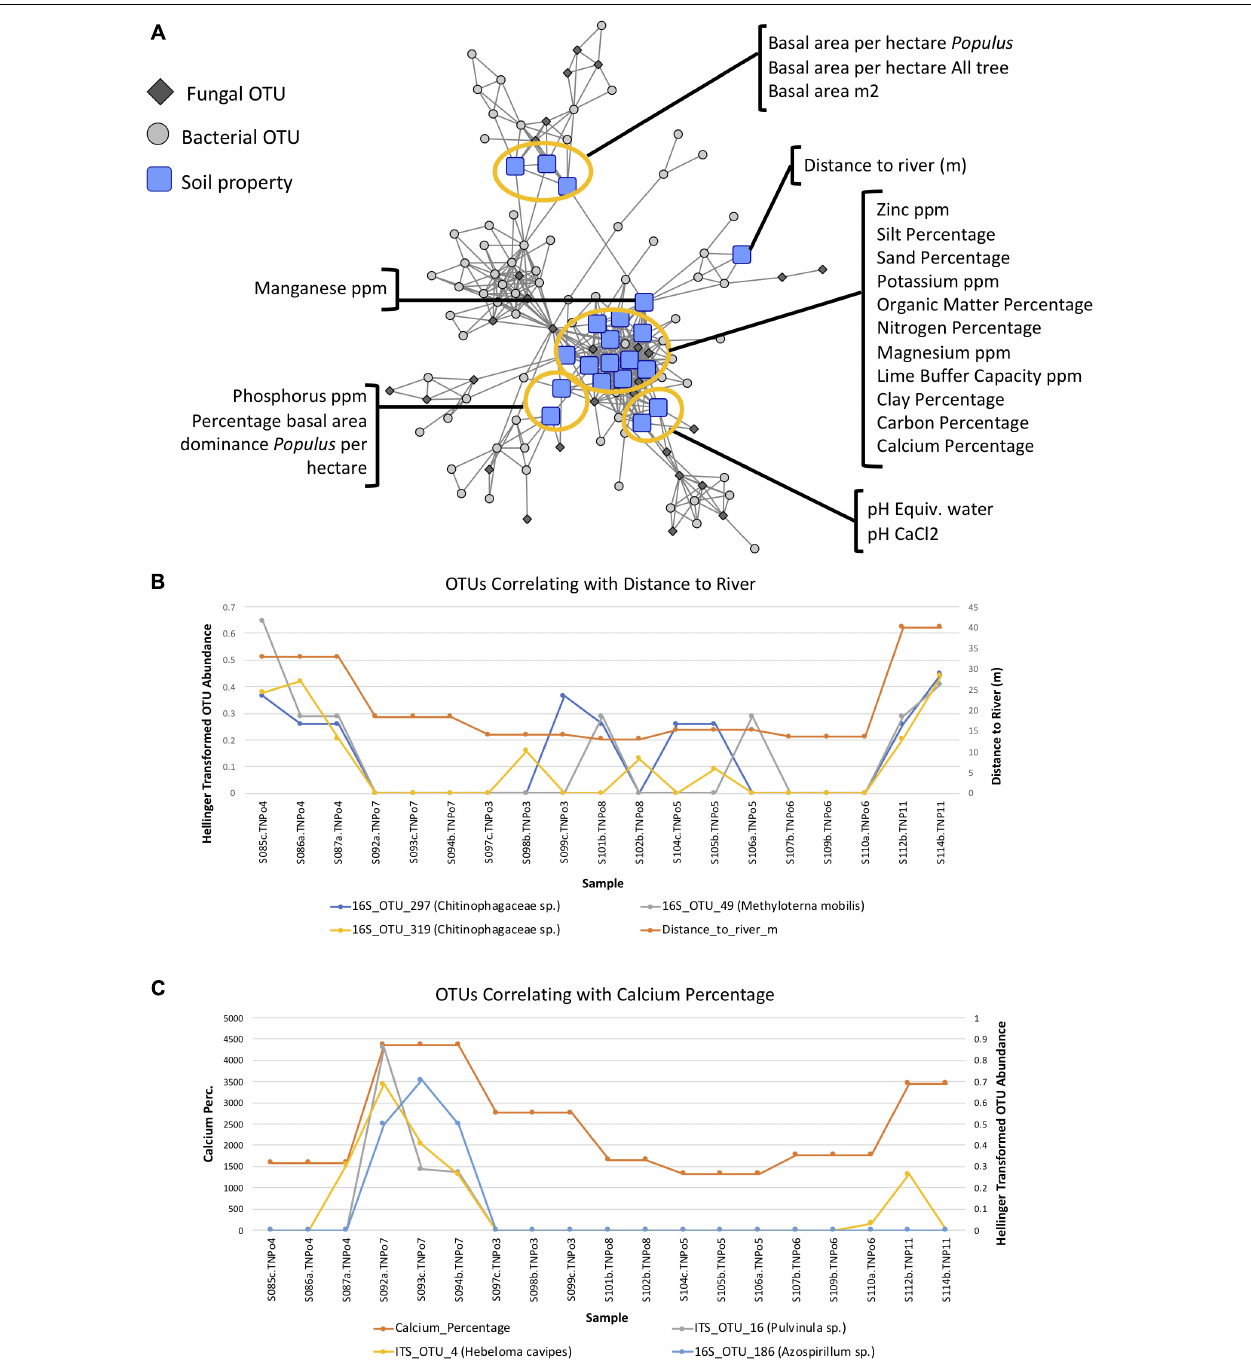
FIGURE 10 | (A) Pearson correlation network of operational taxonomic unit (OTU) communities and soil physicochemical/environmental parameters at a threshold of | Pearson| ≥ 0.6, indicating the correlation between the various soil properties with OTU abundance across samples in Experiment 2: Soil origin. (B) Example of 3 OTUs whose abundances correlate with distance from the river. (C) Example of three OTUs whose abundances correlate with calcium content of